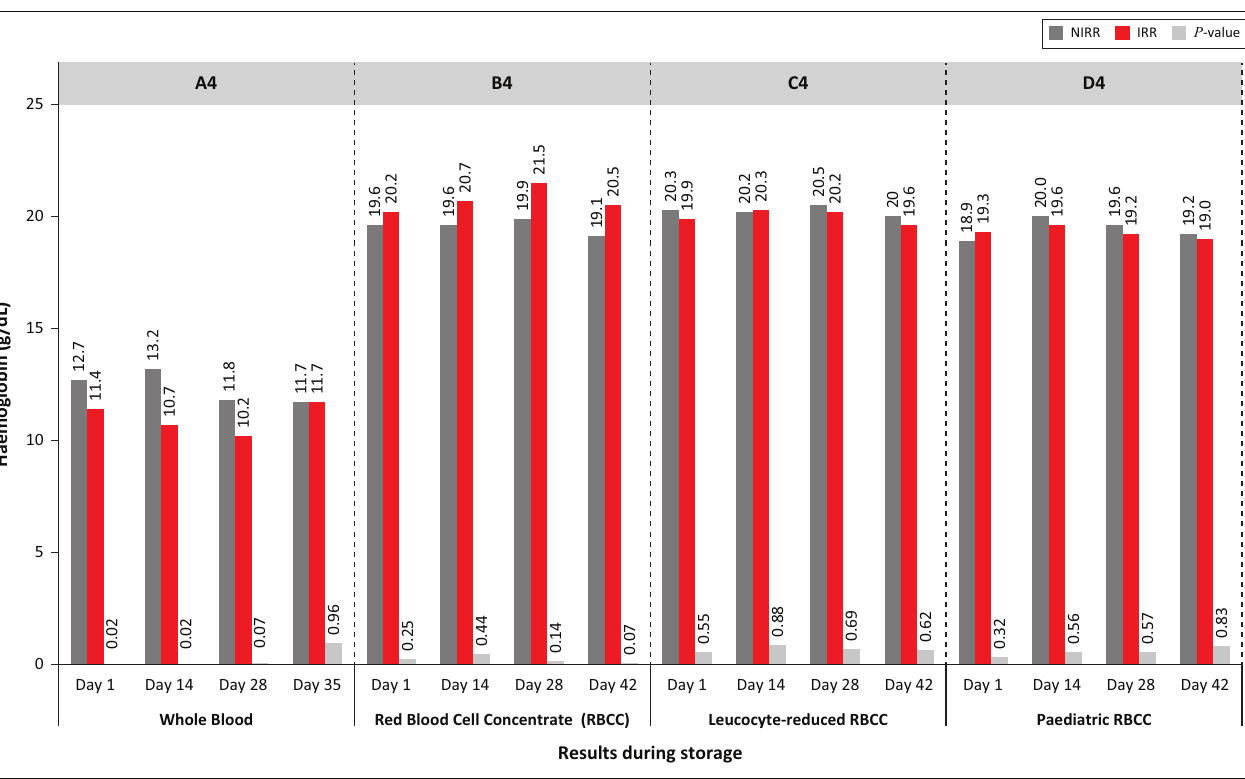
IRR, irradiated; NIRR, non-irradiated; RBCC, red blood cell concentrate FIGURE 4: Haemoglobin (Hb)